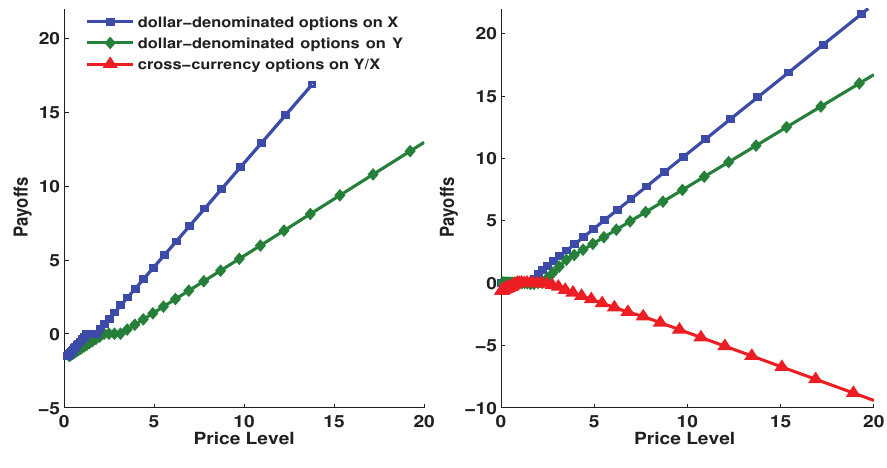
Figure 5. Static Sub-replicating Strategies . The time-zero prices of the exchange rates X and Y are 1.6 and 2.5. The volatilities of the processes X and Y are 42%, and two processes are correlated with ρ = 0.20. Both the domestic and foreign interest rate are zero. The basket option b with 1-year maturity has the payoff [ 1.2 X + 0.9 Y − 3.8 ] + . The dominated strategies are attained within a price mesh of u = 1.12 and J = 30. In the left panel, the relevant strike on X ( Y ) is ( 1.42,2.01 ) ( ( 1.99,2.80 ) ). In the right panel, the relevant strikes on X ( Y ) are ( 1.72,2.24 ) ( ( 2.23,3.93 ) ), and the strikes on Z are